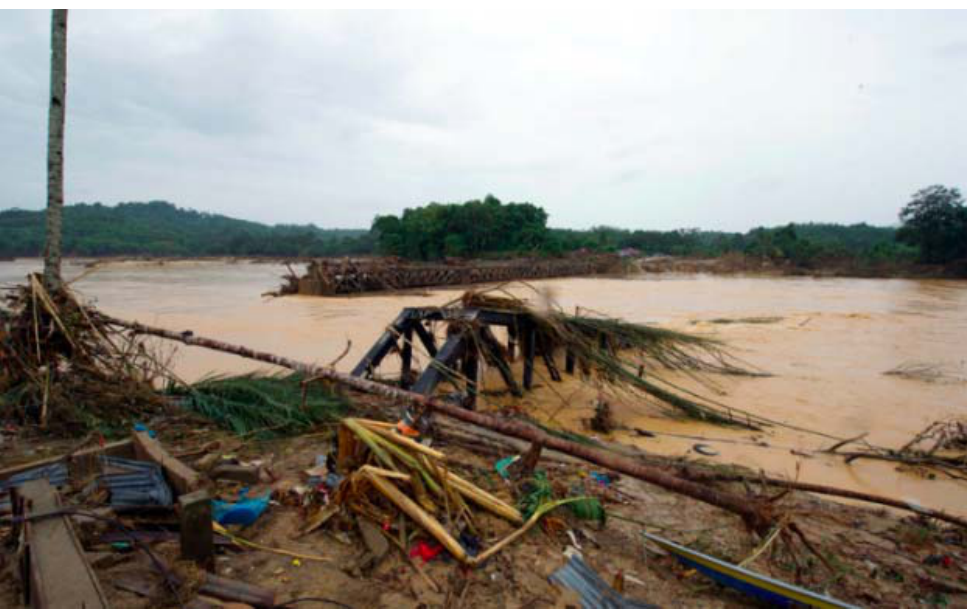
Figure 5. Malaysia East Coast Line railway bridge which crosses Nenggiri River in Kemubu, Kelantan was completely lost due to massive flooding in December 2014 (courtesy: Malaysia Department of Public Works).